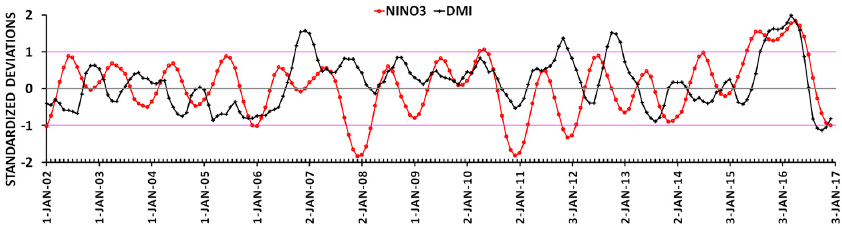
Figure 11. Thirty years (1986–2015) standardized anomaly five months retrospective smoothed time series plots of NIÑO3 (red) and DMI (black) for 2002–2016. Pink horizontal lines represent ± standard deviation.